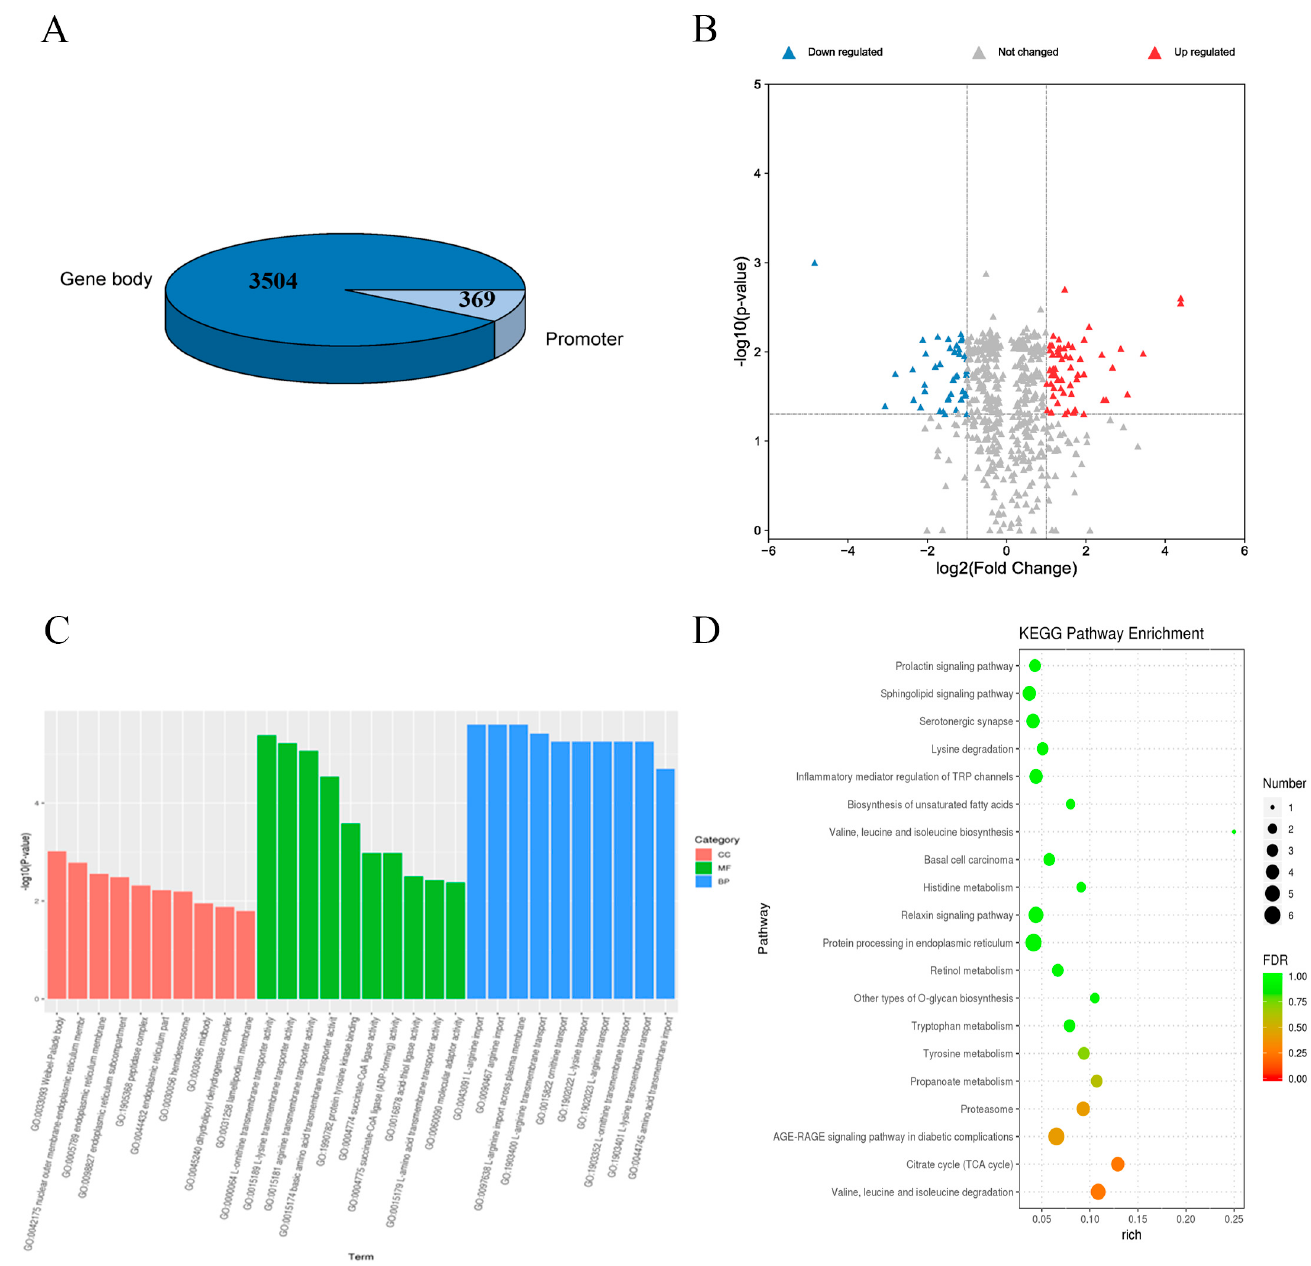
Figure 1. Statistics of DMGs. ( A ) Statistics of total DMRs identified by WGBS-seq. ( B ) Volcano diagram of DMGs in promoter regions. ( C ) GO promoter region analysis. ( D ) KEGG bubble chart of promoter region.